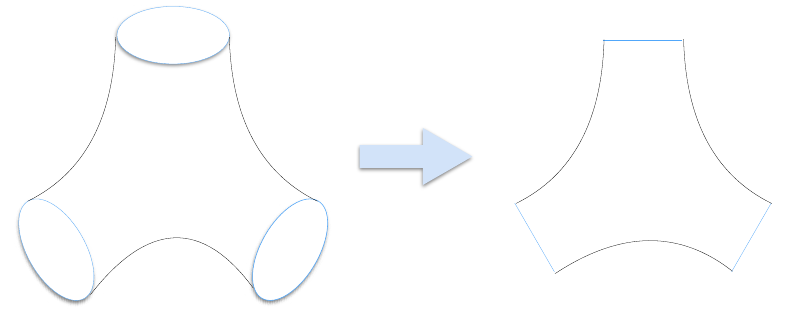
Figure 3 . Three closed strings worldsheet to three open strings